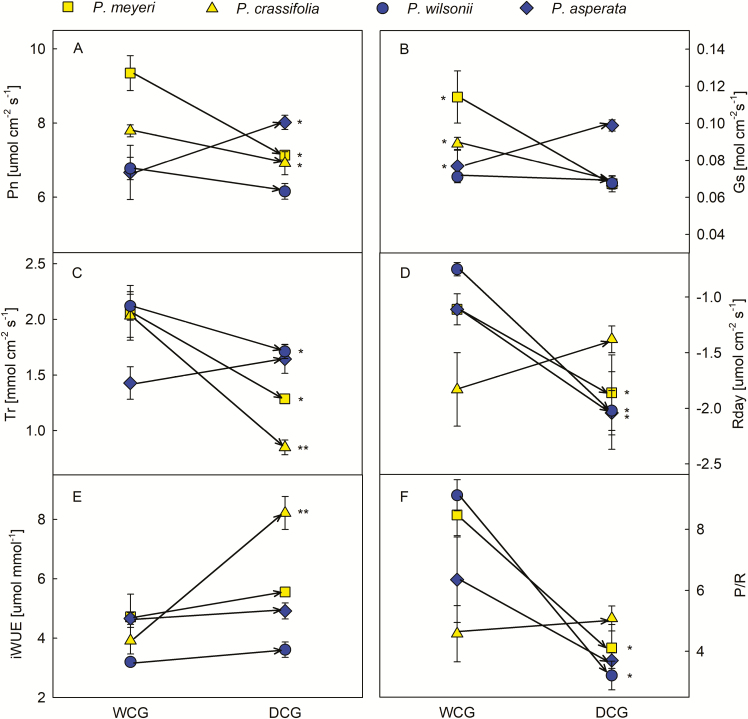
Differences in photosynthetic traits between WCG and DCG for each species. Yellow symbols indicate the species from the dry habitat and blue symbols indicate the species from the wet habitat. The lines show mean values and standard error of means across three replicates for each measurement, plotted against drought treatments. (A) Pn is net photosynthetic rate; (B) Gs is stomatal conductance; (C) Tr is transpiration rate; (D) Rday is respiration rate during daytime darkness; (E) iWUE is instantaneous efficiency of water use; (F) P/R is photosynthesis/respiration ratio. *P < 0.05 and **P < 0.01.